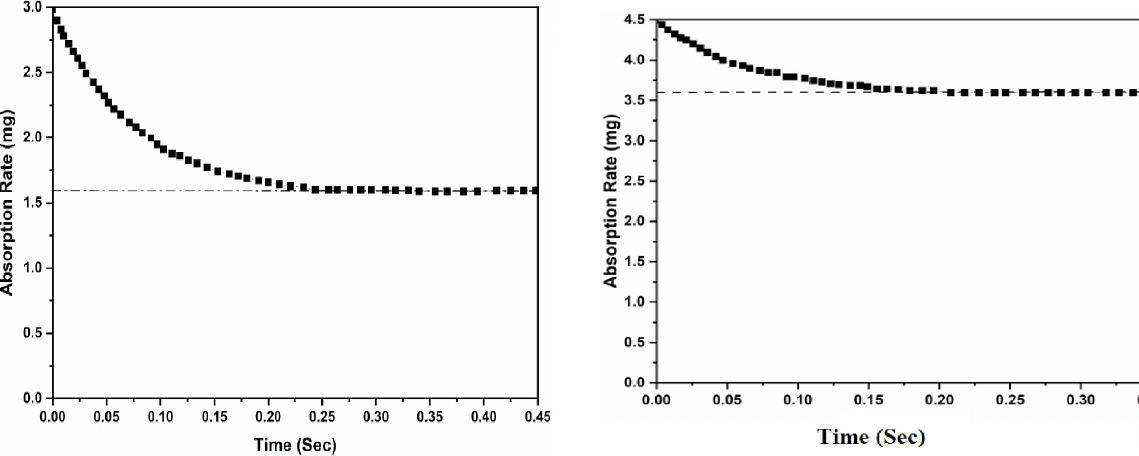
Figure 10 . Response of the Dermis and Tissue Layer. Figure 11. Response of Three